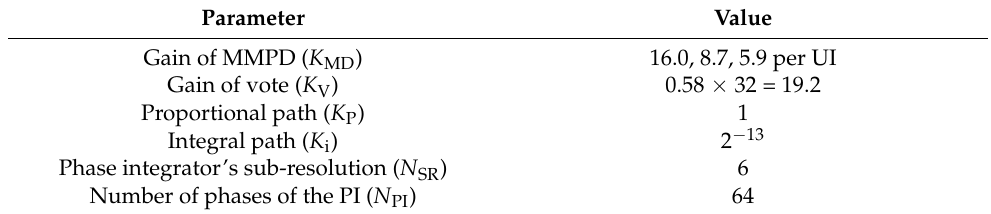
Table 3. MM-CDR parameter